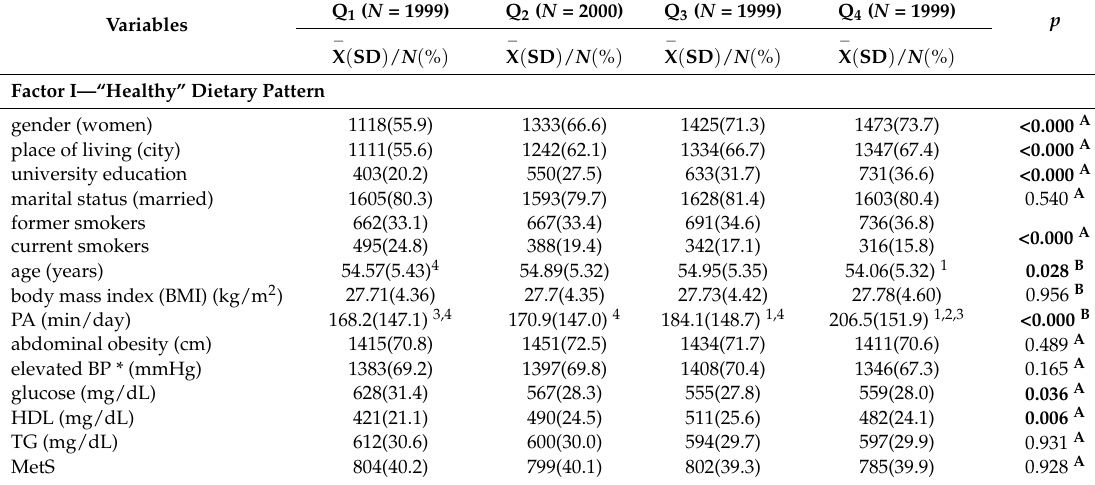
Table 2. The characteristic of the study participants in quartile categories of the dietary patterns ( N , %). Values above the cutoff were given for MetS